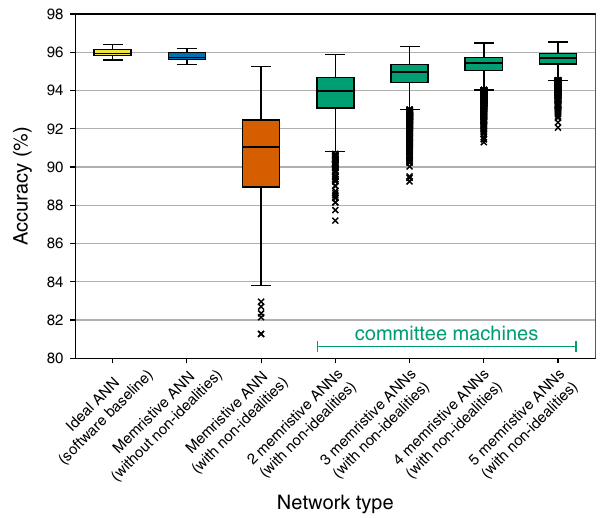
Fig. 4 Accuracy of committee machines when using Ta/HfO 2 devices. Accuracy achieved by individual networks and their committees when faulty devices, D2D variability data, and line resistance of Ta/HfO 2 crossbar are taken into account. The maximum whisker length is set to 1.5 ×